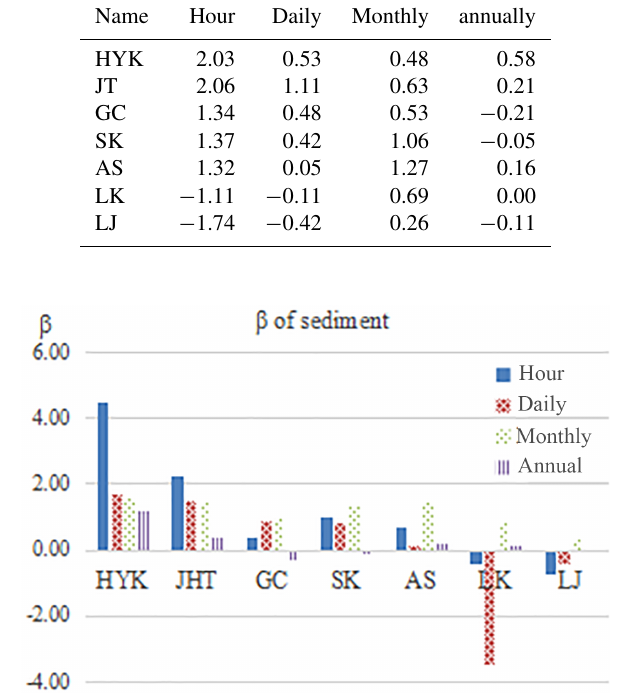
Figure 2. β of sediment in different time scale (HYK: Huayuankou; JHT: Jiahetan; GC: Gaocun; SK: Sunkou; AS: Aishan; LK: Luokou; LJ: Lijin).